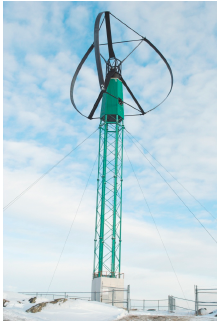
Figure 1. “Cap d’Ours”, a curved, three ‐ blade, Darrieus ‐ type VAWT.